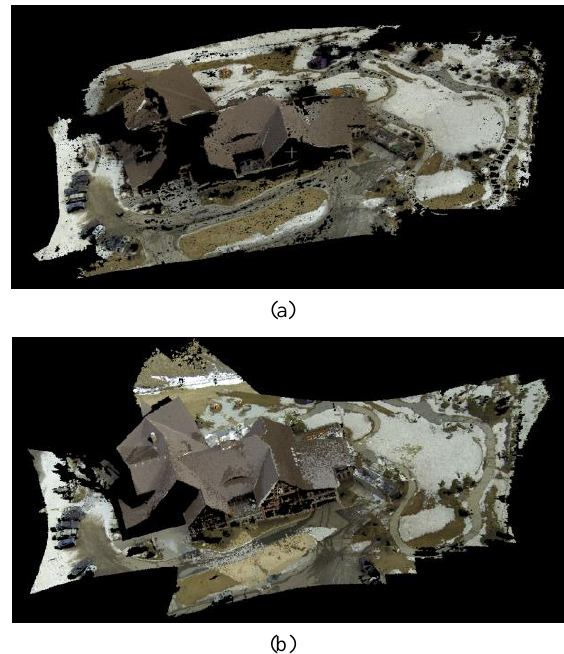
Figure 2: The impact of accurate system calibration on the quality of reconstructed 3D surface using images collected by a low-cost camera mounted on a UAV system: (a) reconstructed 3D surface without considering accurate system calibration parameters, and (b) reconstructed 3D surface while considering accurate system calibration parameters